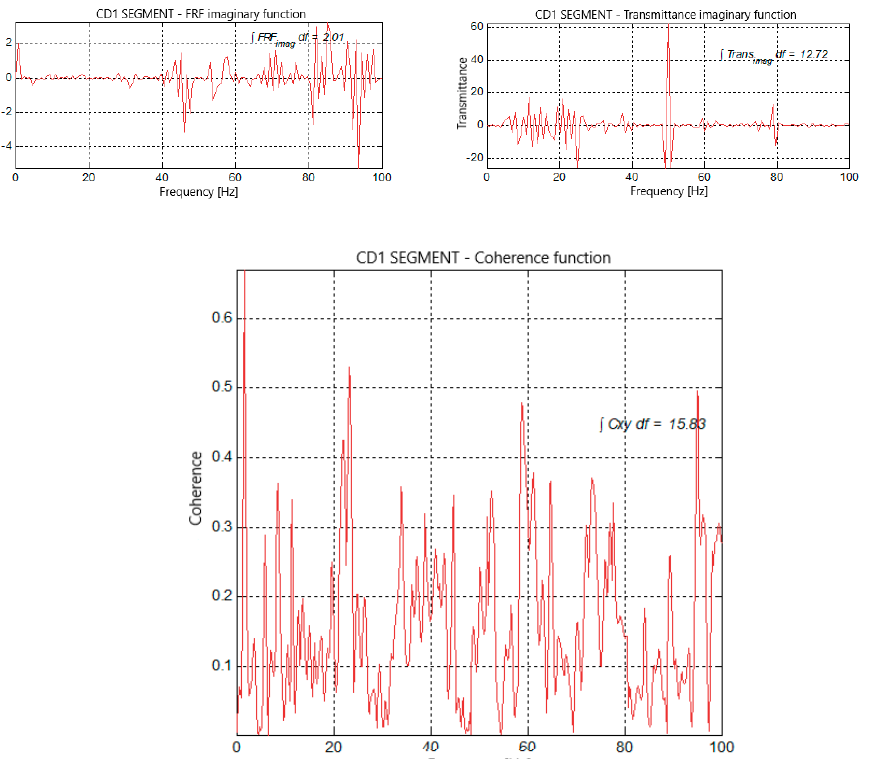
Figure 10. Vibration measures results for CD1 segments. The vibration signal measurements of tested CR1 segments are shown on the X-axis.